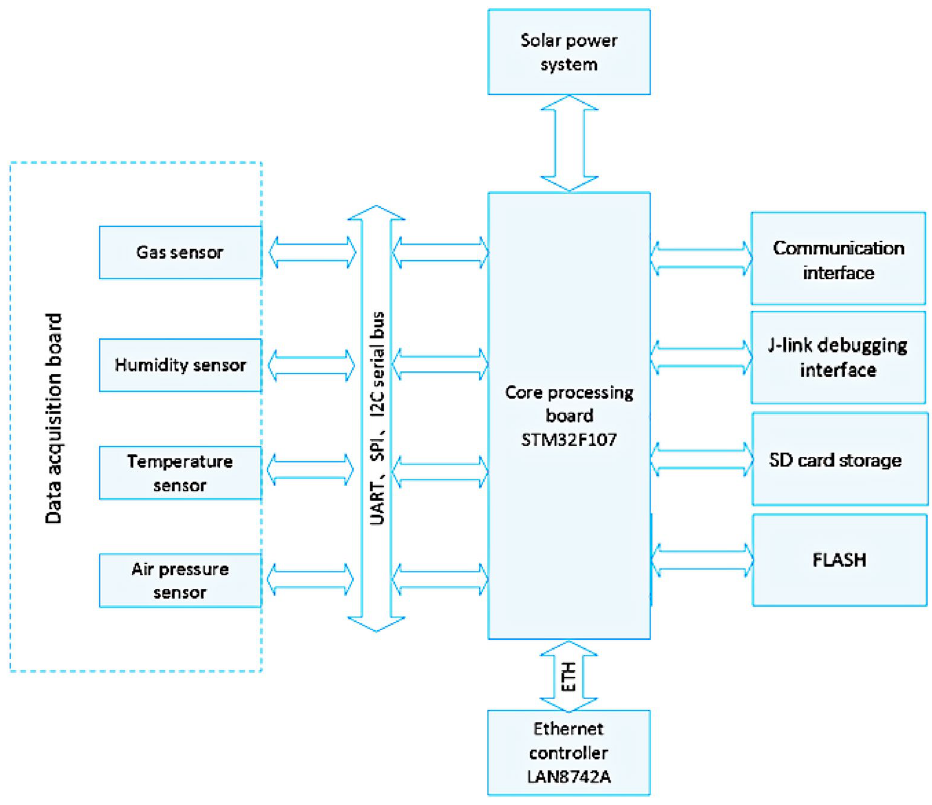
Figure 1. The entire hardware